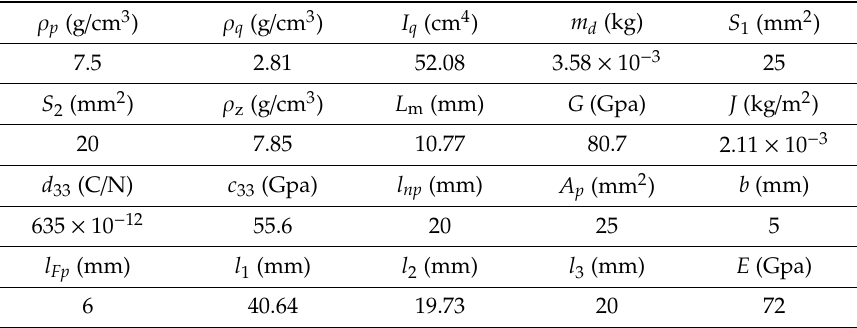
Table 1. Free vibration calculation parameters.